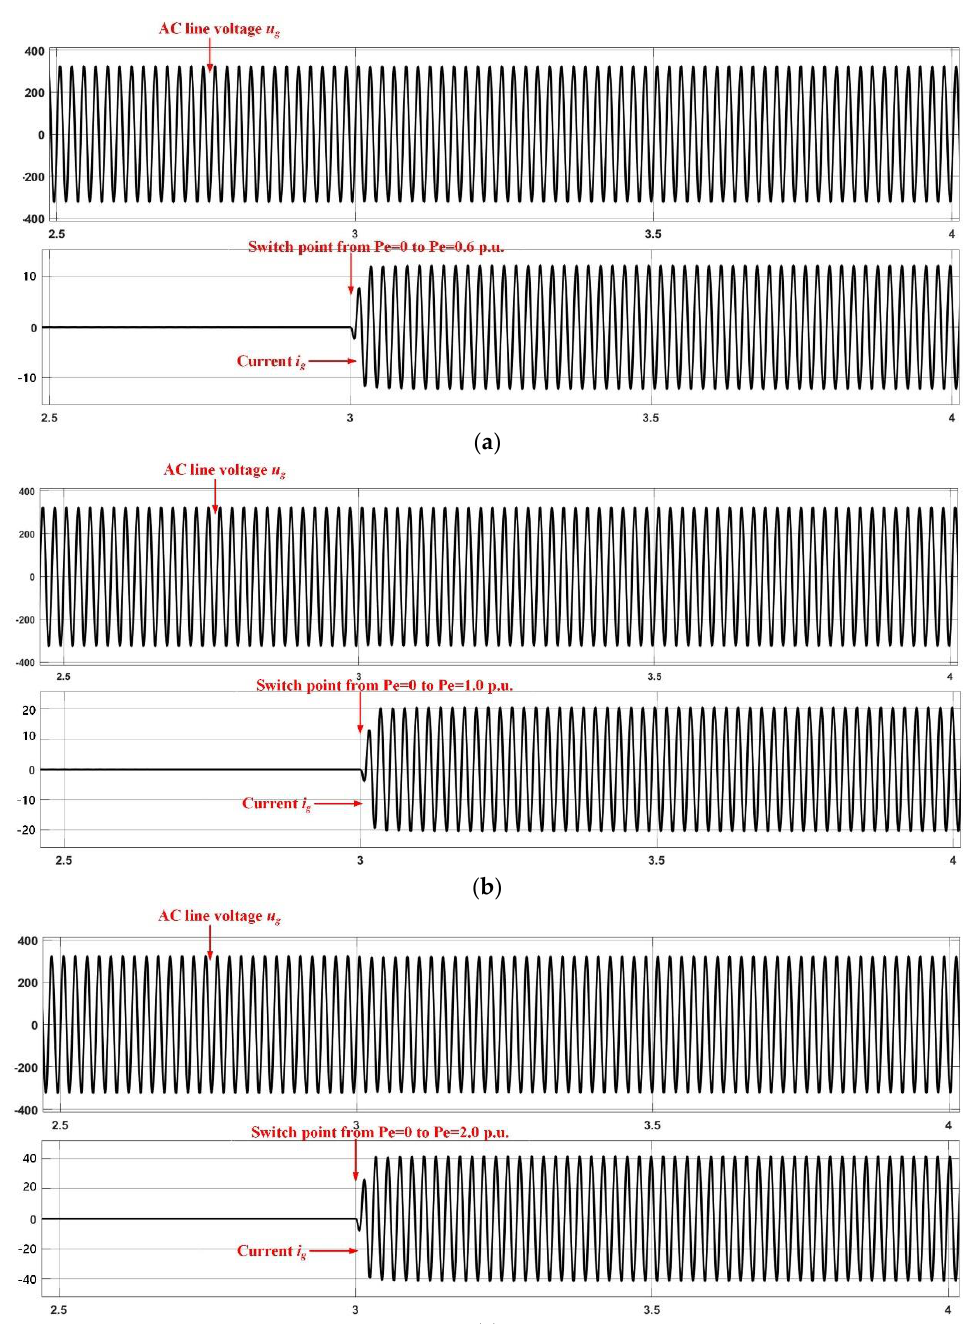
Figure 19. Dynamics of AC line voltage, synchronverter current, and disturbance with the switching operating point: ( a ) from P e = 0 to P e = 0.6 p.u.; ( b ) from P e = 0 to P e = 1.0 p.u.; ( c ) from P e = 0 to P e = 2.0 p.u.